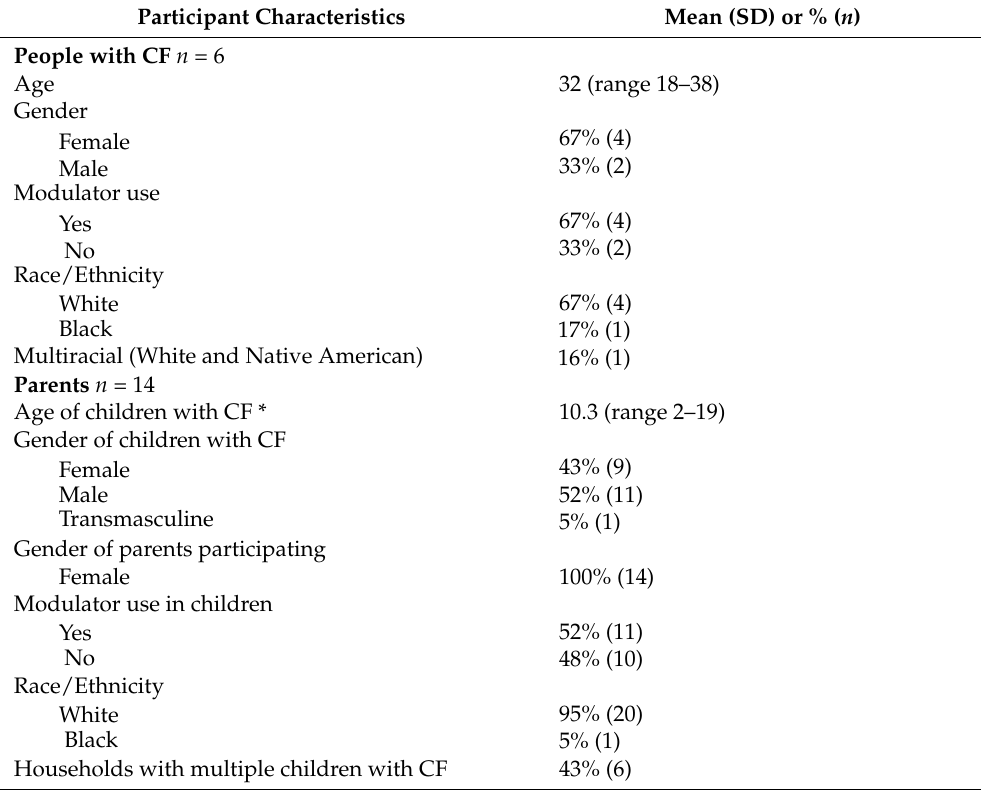
Table 1. Characteristics of the CF patient